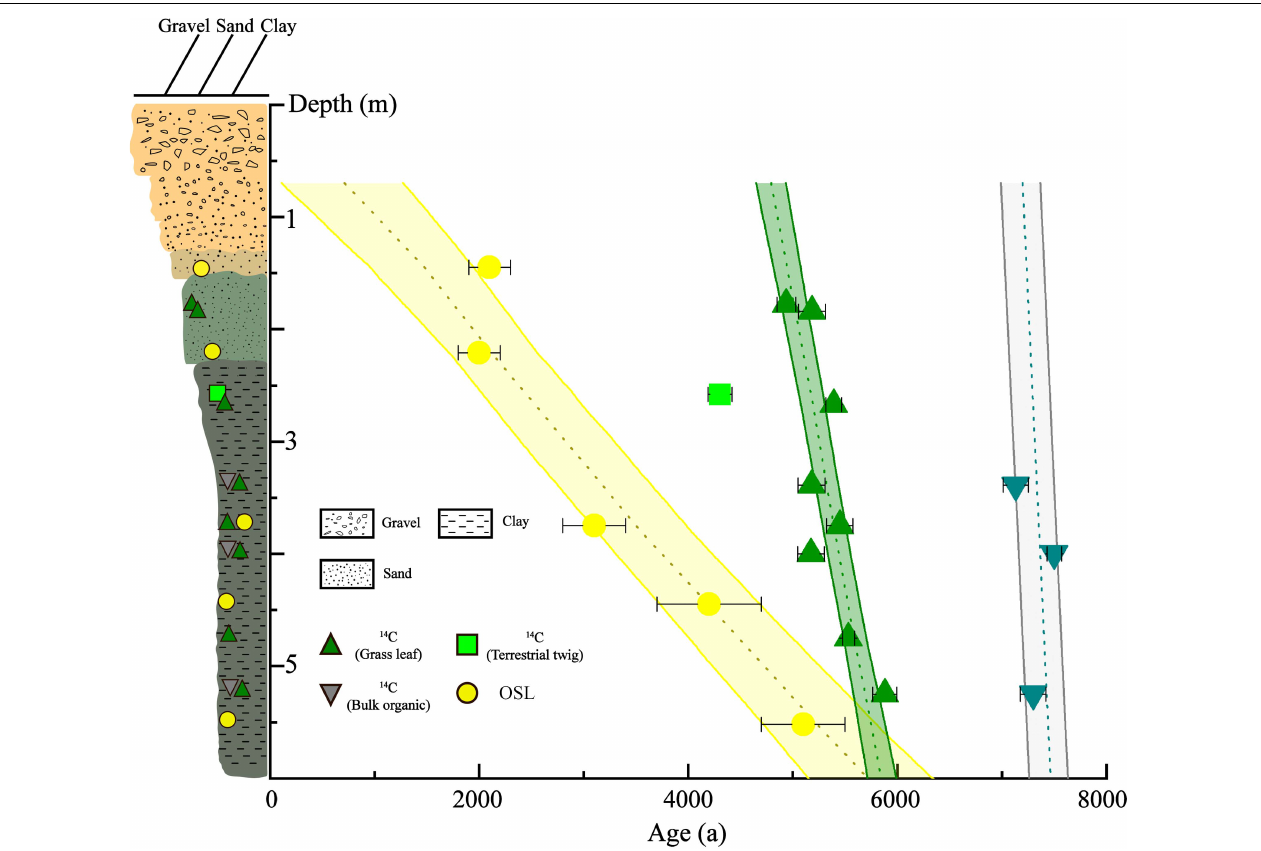
FIGURE 4 | Stratigraphy of the lacustrine sediment sequences and the ages of section CQ discussed in the text. The three shaded areas are the age-depth models of lacustrine sediment. The yellow shaded area is the OSL age-depth model, and the green and gray shaded areas are the age-depths of aquatic plant remnants and bulk organic matter, respectively. Three dotted lines are the median ages. Because there was only one 14 C age of TPR, we did not use it to build the age-depth